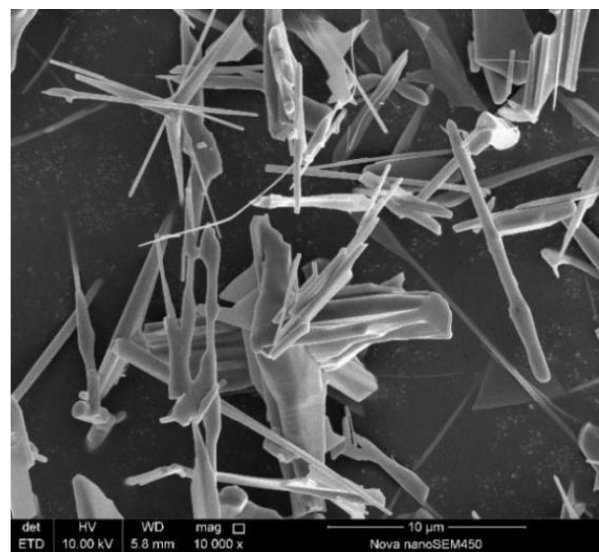
Figure 10. SEM images of ZnO product.